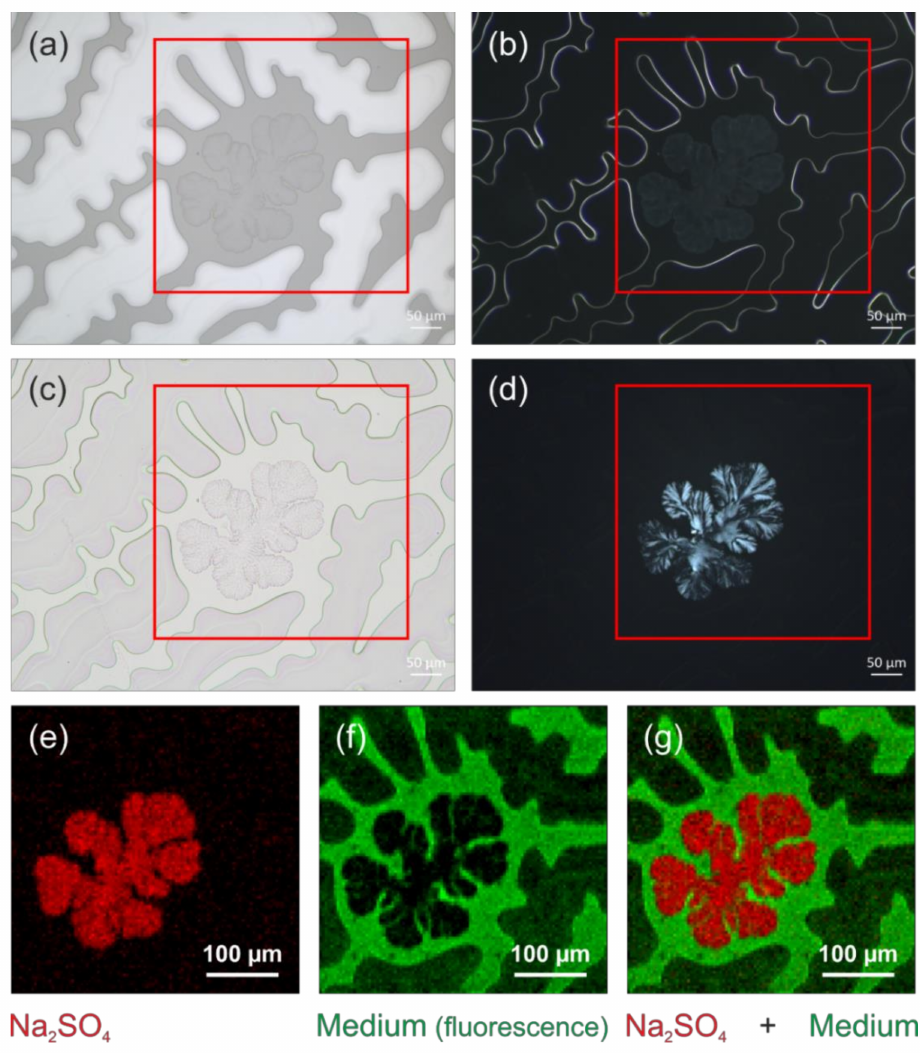
Figure 18. Example of crystal precipitation in an unknown mounting medium, sample USNM 1226589, Cateria styx : ( a ) reflected light brightfield, ( b ) reflected light darkfield, and ( c ) transmitted light micrograph with parallel and ( d ) crossed polarisers, ( e ) Raman distribution map of Na 2 SO 4 (based on the intensity of the most prominent Raman band of the mineral thenardite), ( f ) distribution map of medium (based on the intensity distribution of its autofluorescence emission), and ( g ) overlay of both distribution